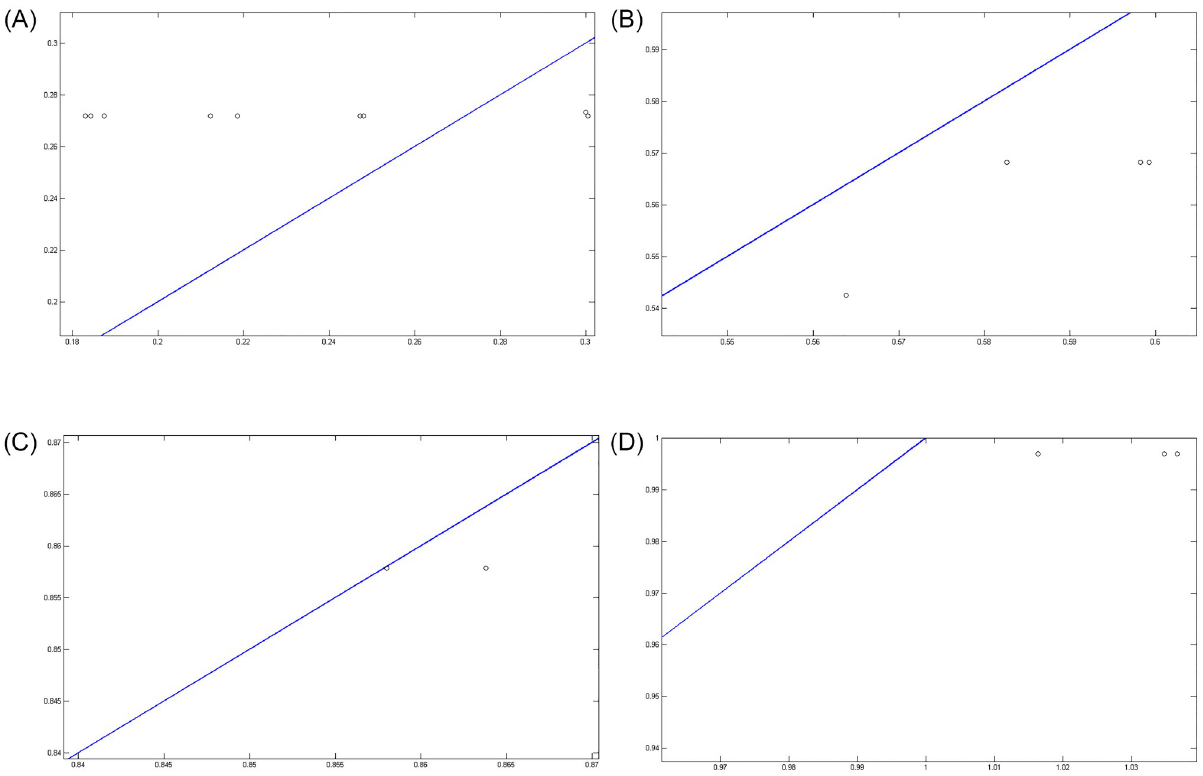
Fig 12. The closest answer to the regression line (regression function) obtained with ANN-BTA in the testing samples: (Fig 12A)[0.1, 0.4], (Fig 12B) [0.4, 0.7], (Fig 12C)[0.7, 1] and (Fig 12D)[1, 1.3] range.